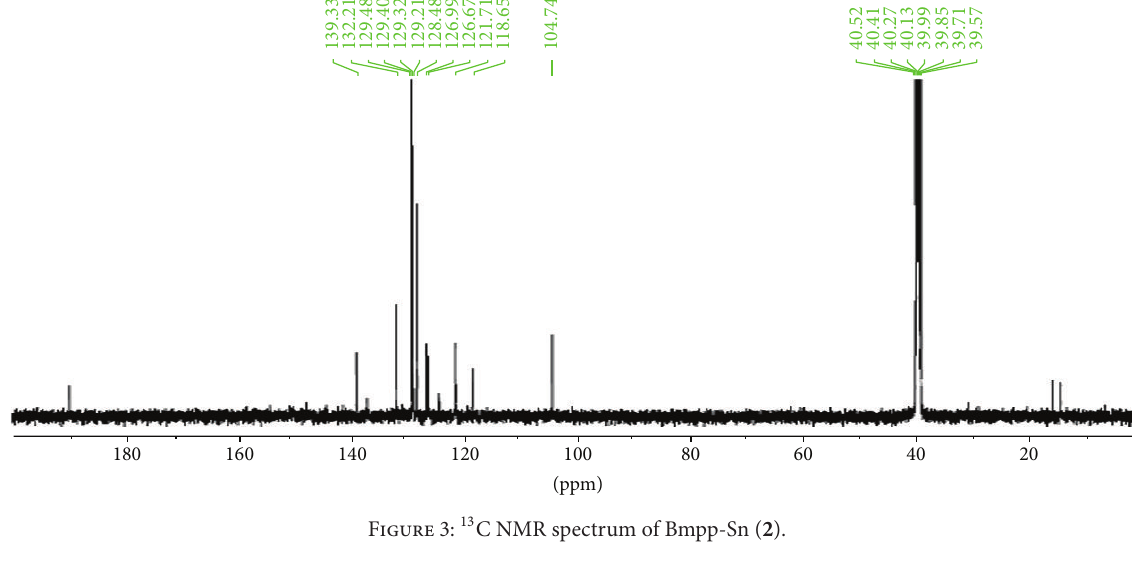
Figure 3: 13 C NMR spectrum of Bmpp-Sn ( 2 ).